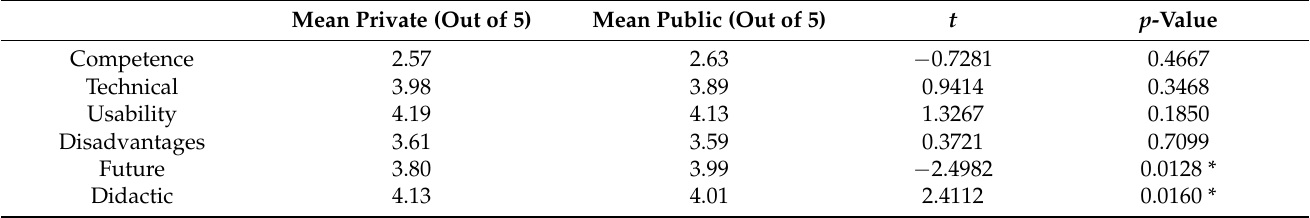
Table 4. Mean responses (out of five) and the statistics of the bilateral t-test for the comparison of the means for independent samples when participants are differentiated by their university tenure (270 participants).